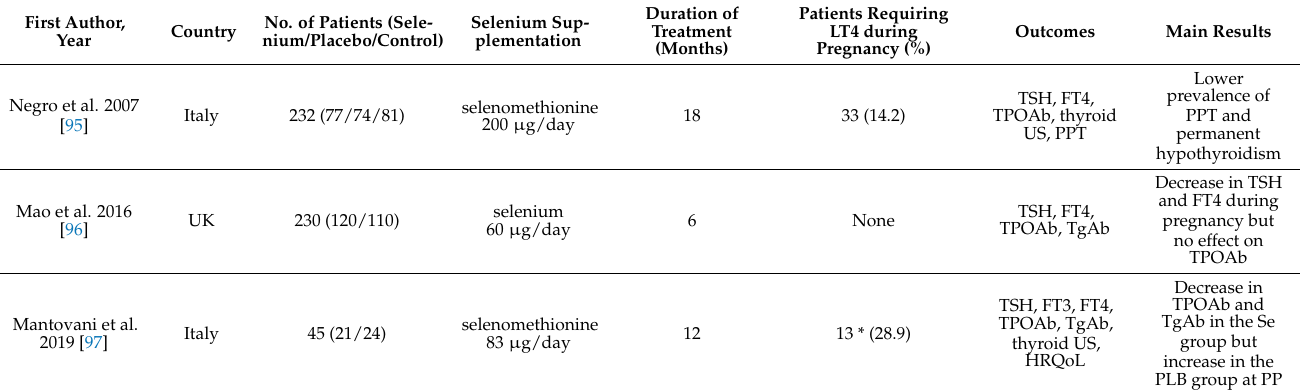
Table 3. Details of selenium supplementation trials evaluating thyroid outcomes in pregnant